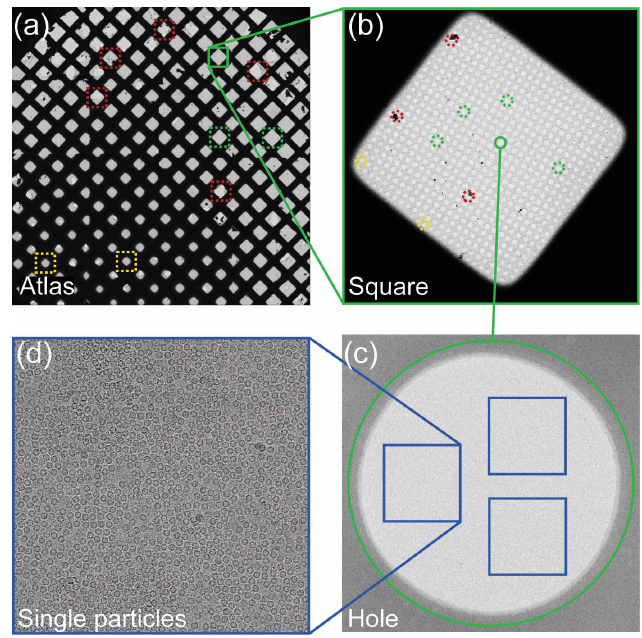
Figure 1 Required target selection steps during single-particle cryo-EM data acquisition. ( a ) Low magnification overview (Atlas) of a cryo-EM grid. Human operator choices for squares that are suitable for imaging are marked with green boxes. Yellow and red boxes represent operator choices of squares with thick ice layers or broken support film, respectively. ( b ) Square with examples of operator choices of holes that are suitable for cryo-EM imaging marked with green circles. Yellow and red circles mark operator choices of holes that have suboptimal ice thickness or are covered by ice contamination, respectively. ( c ) High- magnification image of a hole with a thin ice layer. Areas for cryo-EM data acquisition are marked with blue boxes. ( d ) Cryo-EM image acquired under optimal conditions and in thin ice showing single particles of good